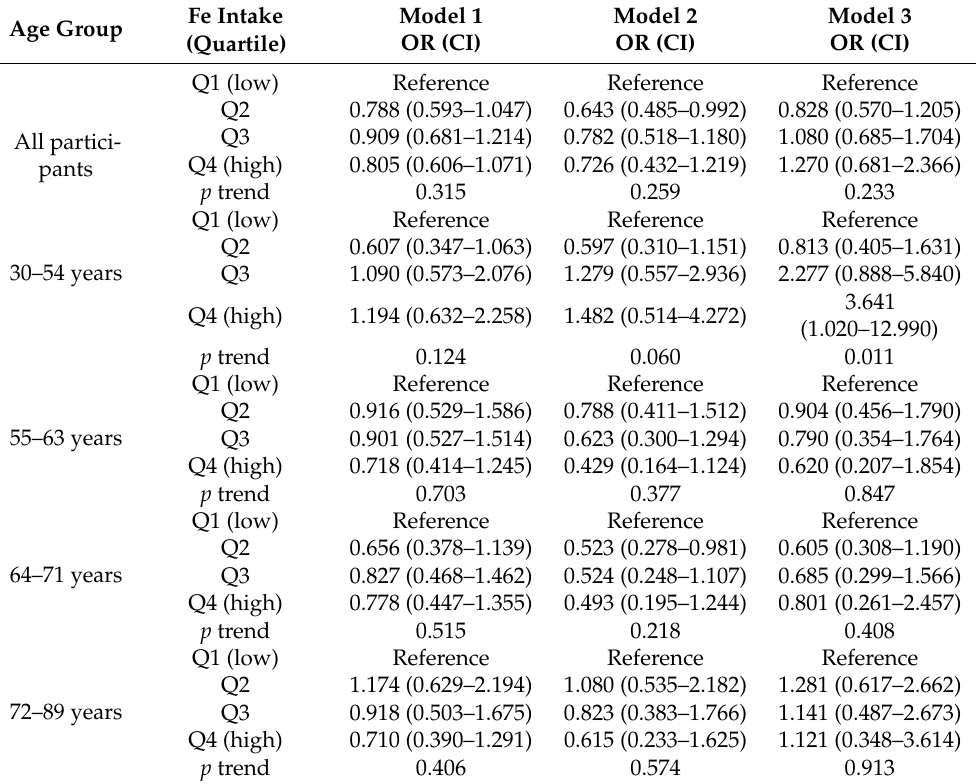
Table 2. Binary regression analysis of quartiles of Fe intake and obesity by quartiles of age group adjusted by